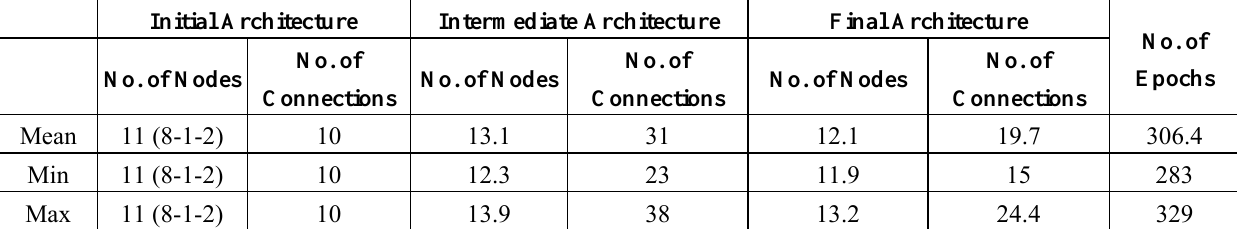
Table 3. ANN architectures and the training epochs for the diabetes dataset.